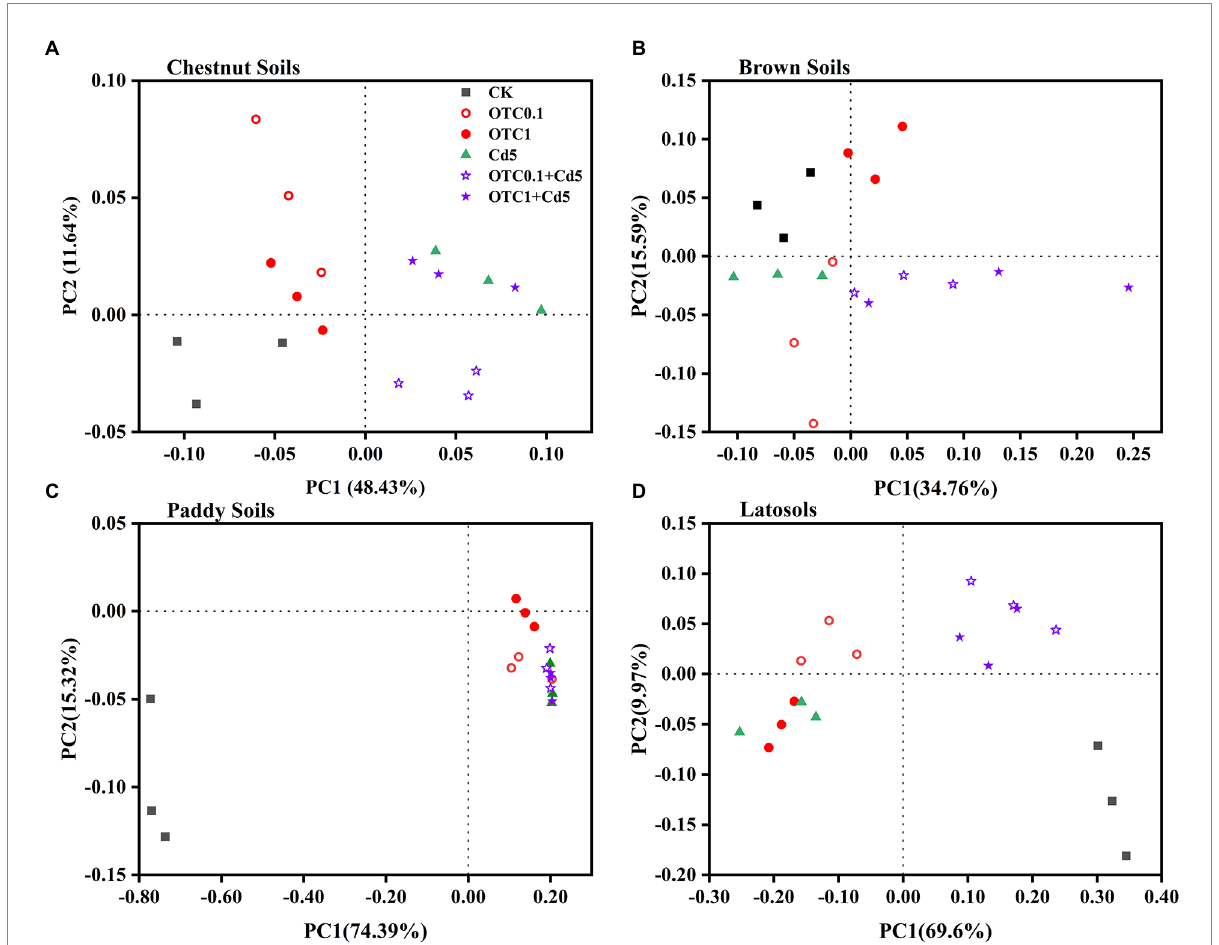
FIGURE 6 Principal coordinate analysis (PCoA) of the Bray–Curtis distance matrix representing differences in the community structure of AOB under CK, OTC0.1, OTC1, Cd5, OTC0.1 + Cd5, and OTC1 + Cd5 treatments in chestnut soils (A) , brown soils (B) , paddy soils (C) , and latosols (D) . CK, control